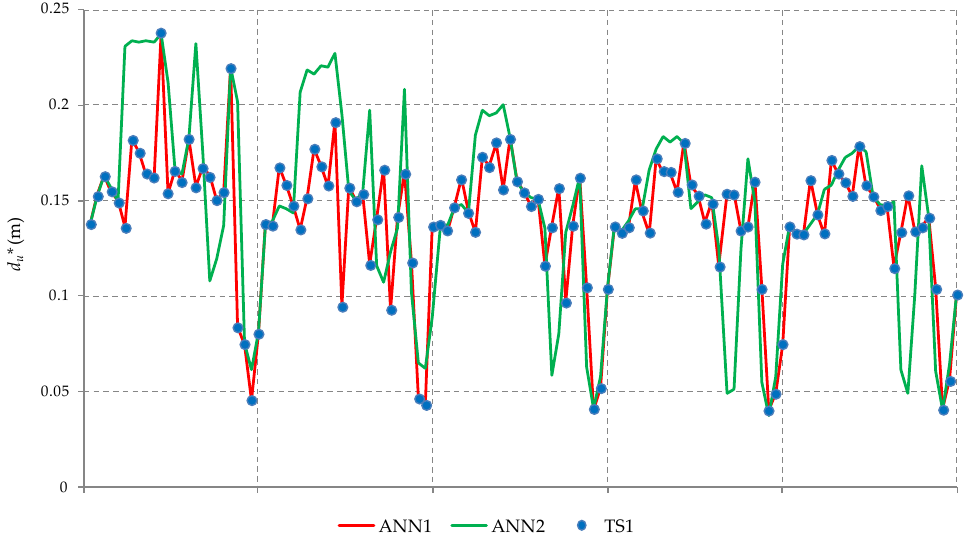
Figure 10. Results comparison for the d u* values.